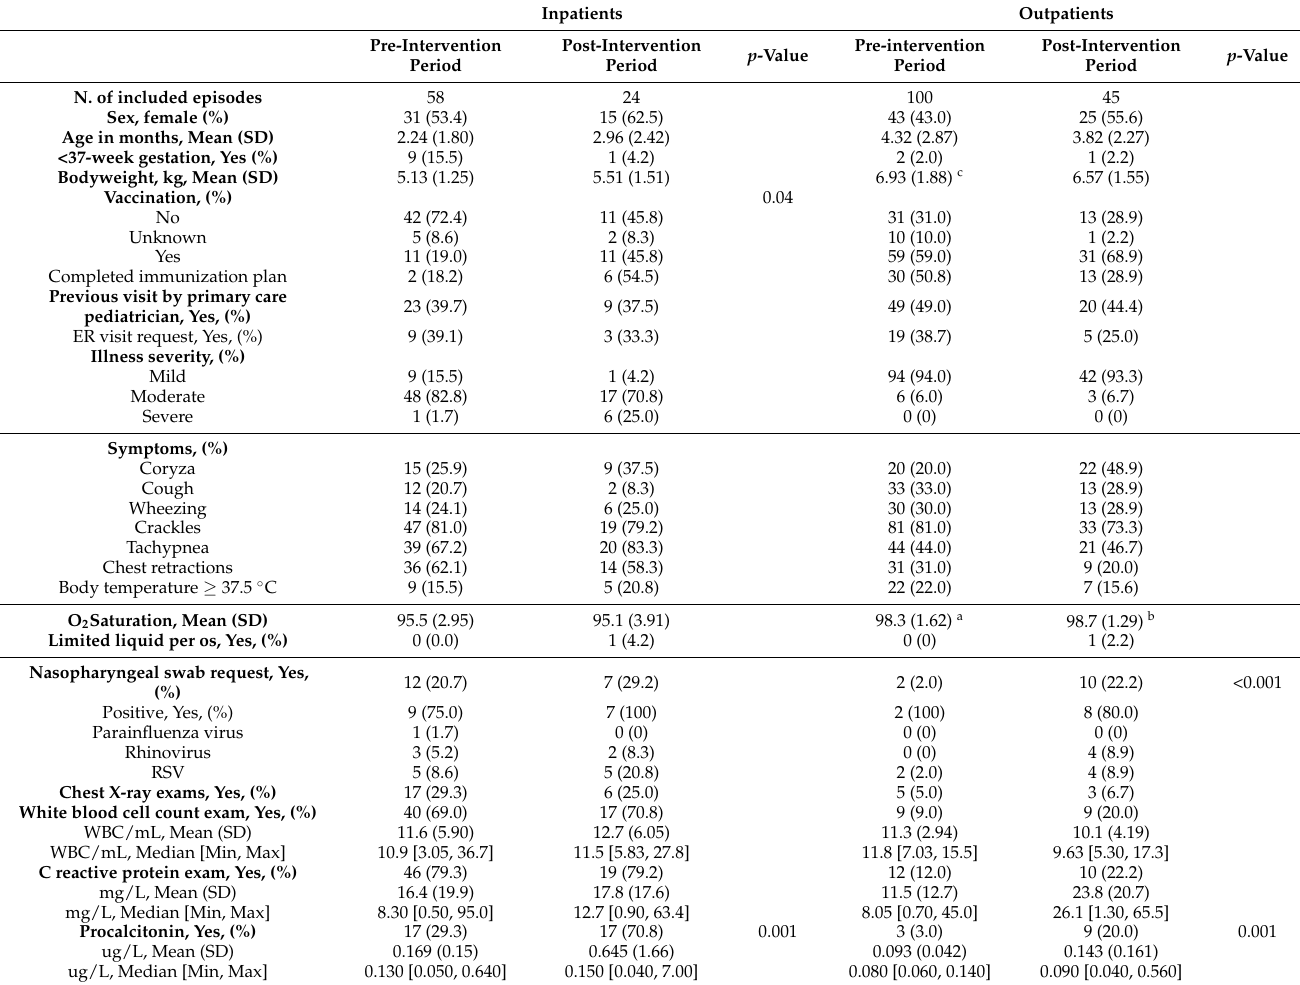
Table 1. Demographics, signs and symptoms, and microbiological and diagnostic exams of patients with bronchiolitis. Statistical comparison was performed only for symptoms, and microbiological and diagnostic exams; and only significant p values are